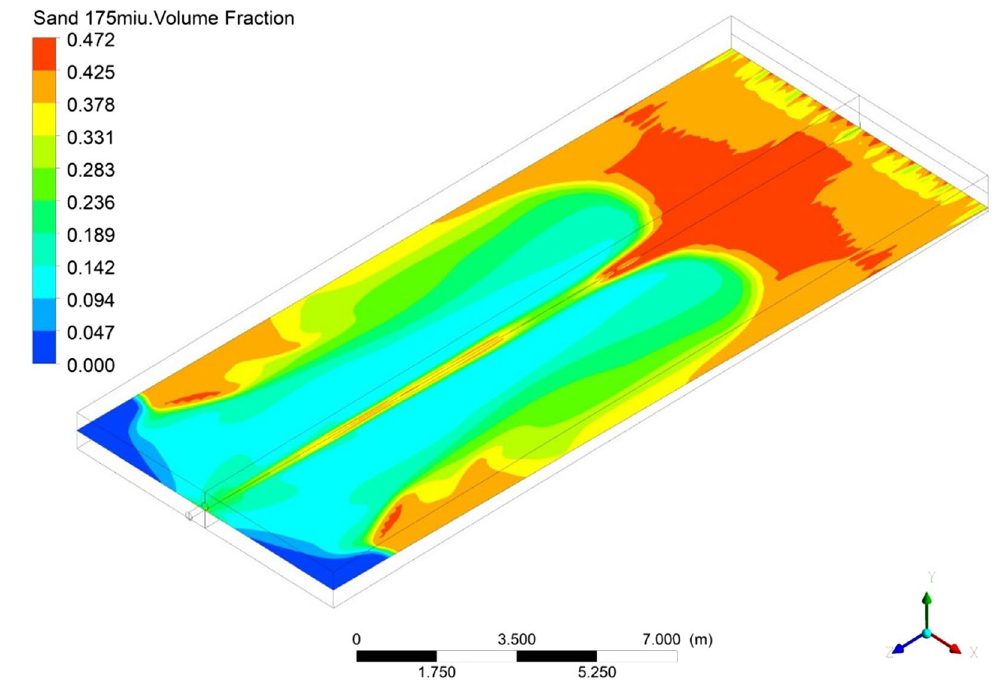
Fig. 12 Volume percentage of 175 μm sediment at 81.515 s